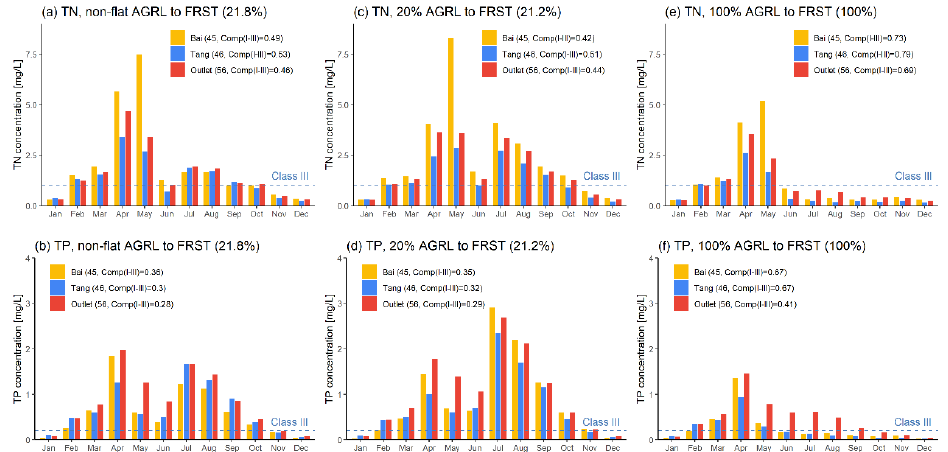
Figure 8. Comparison of mean monthly TN ( a , c , e ) and TP ( b , d , f ) concentrations in pollutant control sections between three different sets of GFG scenarios: converting all non ‐ flat drylands (AGRL with slope > 2.5%) in Henan province to FRST ( a , b ), one scenario of randomly selecting 20% AGRL to FRST based on HRUs ( c , d ), and converting all AGRL land to FRST ( e , f ). As sloping lands are more susceptible to soil erosion, the scatter dots in Figure 7 de ‐ pict the two slope ‐ specific GFG scenarios. It is evident that GFG of sloping drylands (slope > 15°, area = 1.5%) and non ‐ flat drylands (slope > 2°, area = 21.8%) are more effective in controlling nutrient loss than slope ‐ independent GFG scenarios. Using the TN load at the Diwan section (on the Bai River, Figure 7a) as an example, the TN reduction under the 21.8% non ‐ flat dryland GFG is 3.5 times the mean reduction under the 20% slope ‐ inde ‐ pendent GFG; however, water quality compliance rates in this section are not much dif ‐ ferent from each other. This inconsistency is because although GFG of sloping/non ‐ flat drylands reduces the pollutant load considerably, mainly in the main flood season (June to September), TN or TP concentrations during this period are still worse than Class III (Figures 8a,b and 6a,b). To summarize, if the water quality standard is the only benchmark, then improving the nutrient concentration at the provincial boundary sections requires control of both the amount of nutrients being washed out and the timing of their washing out. Thus, enhanc ‐ ing the monitoring and management of water quality, along with the ecological operation of water projects, are the key engineering measures that allow water bodies to self ‐ purify more effectively. The payments of eco ‐ compensation are calculated based on the GFG area and crop yields (Figure 7f). In the baseline scenario without any GFG, the mean annual yields of maize and wheat in TRB within Henan province are 3839.1 and 3740.7 kiloton, respec ‐ tively. The sum of this is close to, but slightly higher than, the statistic annual grain pro ‐ duction of 7105.9 kiloton in Nanyang city in 2019 [58]. The total average annual value of both crops simulated by SWAT is CNY 18.4 billion. The compensation amount consider ‐ ing agricultural opportunity costs increases almost linearly with the increase in GFG area, from CNY 1.81 billion (for 10% GFG) to CNY 18.4 billion (for 100% GFG) (upper line in Figure 7f) per year. When compensation is based on merely the GFG area, the value also increases proportionally, but grows more slowly (lower line in Figure 7f). Under the 100% GFG scenario, the lower value is only one ‐ third of the upper value. This indicates that even under the same ecological restoration strategy, the amount of eco ‐ compensation available to farmers may vary considerably due to the different quantitative criteria adopted.